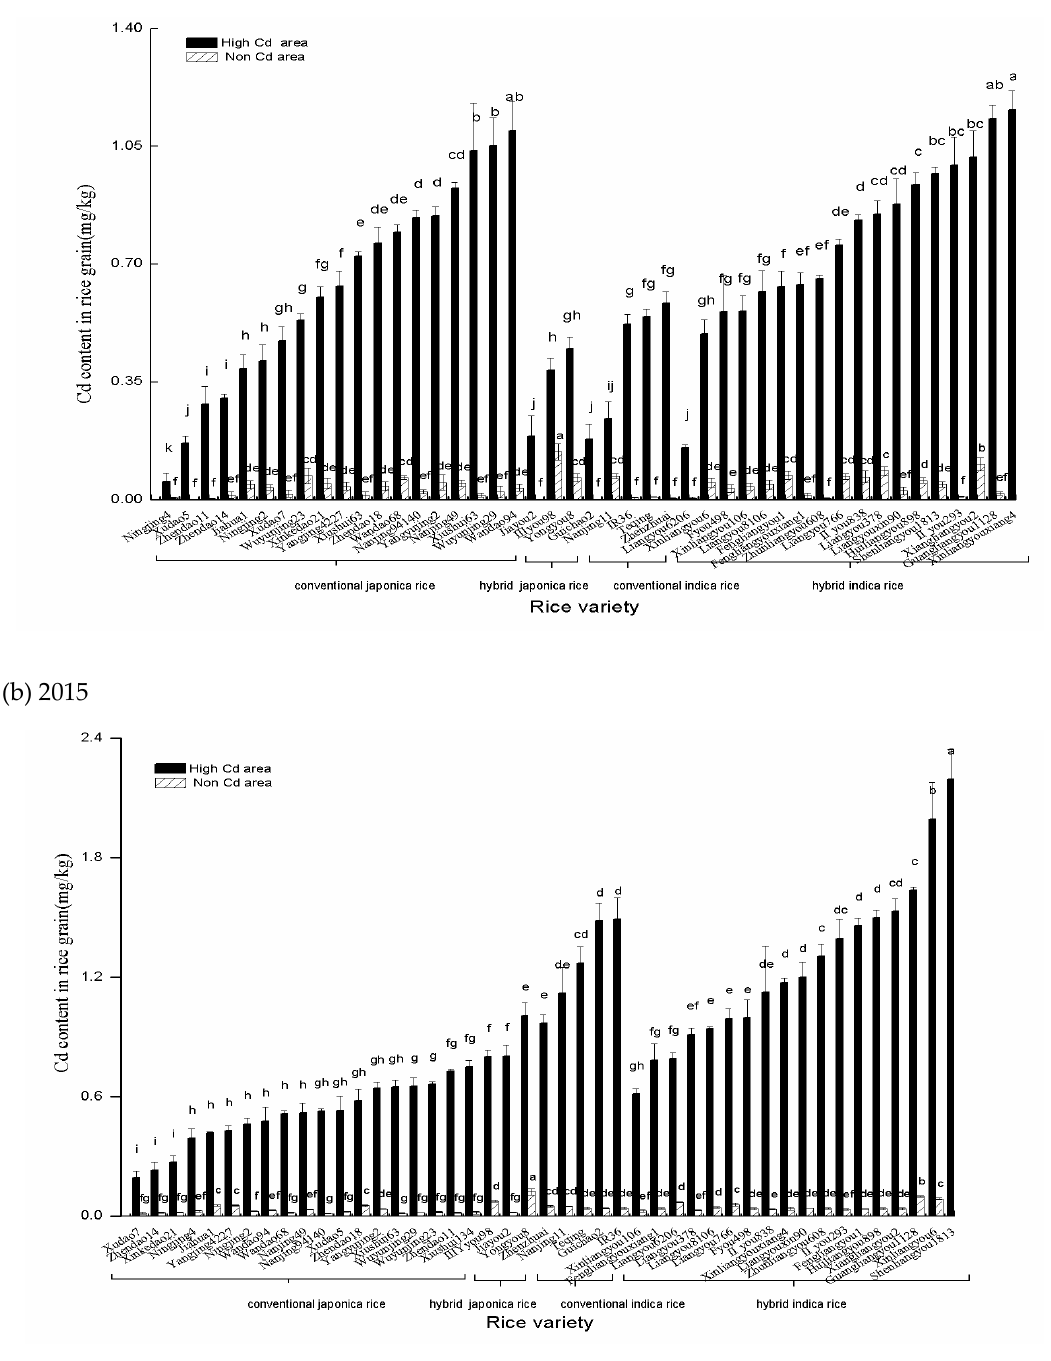
Figure 1. Cd content in rice grains in ( a ) 2014 rice season and ( b )2015 rice season. Different letters above columns indicate significant difference among varieties at 0.05 level.